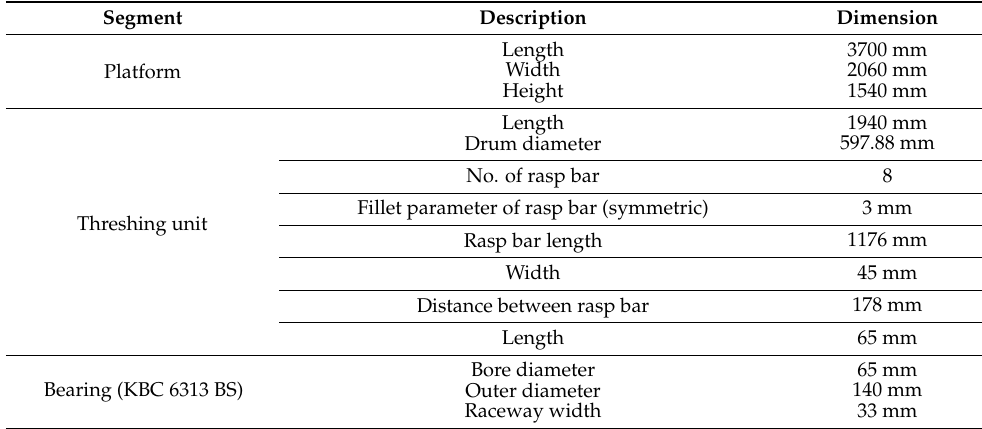
Figure 4. Computer-aided design of the main units of the tangential threshing units of the test bench. Table 3. Tangential threshing unit test bench parameters.